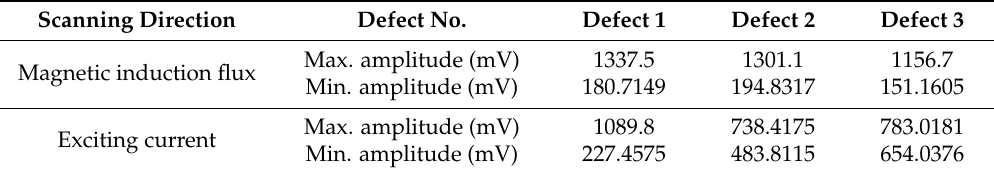
Table 3. Amplitude of surface defects in two directions.